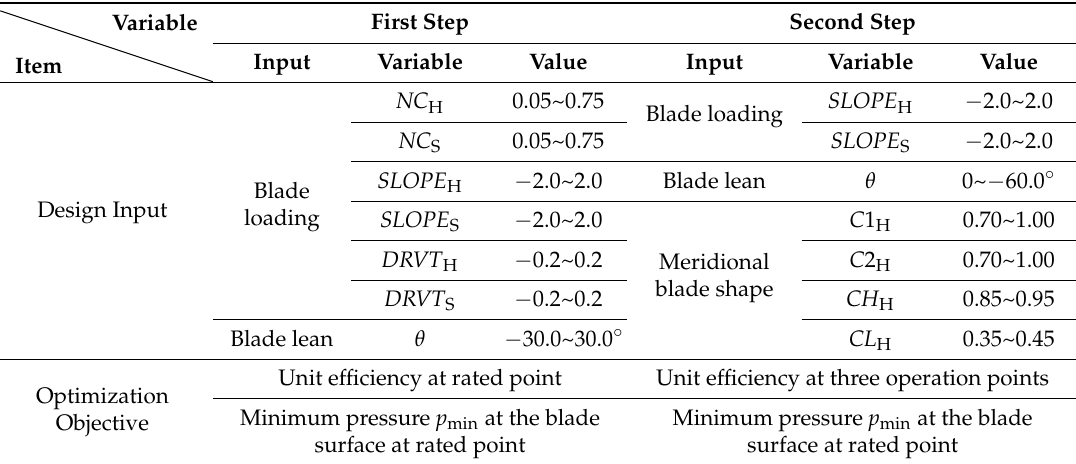
Table 2. Design parameters and objective